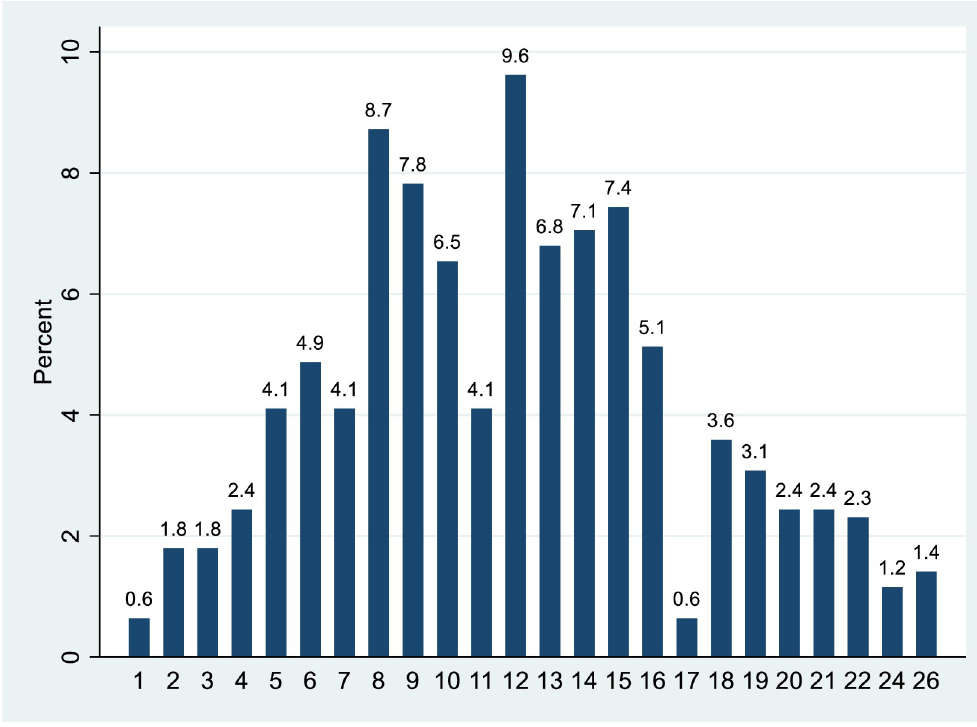
Fig 7. Percentage distribution of people at one